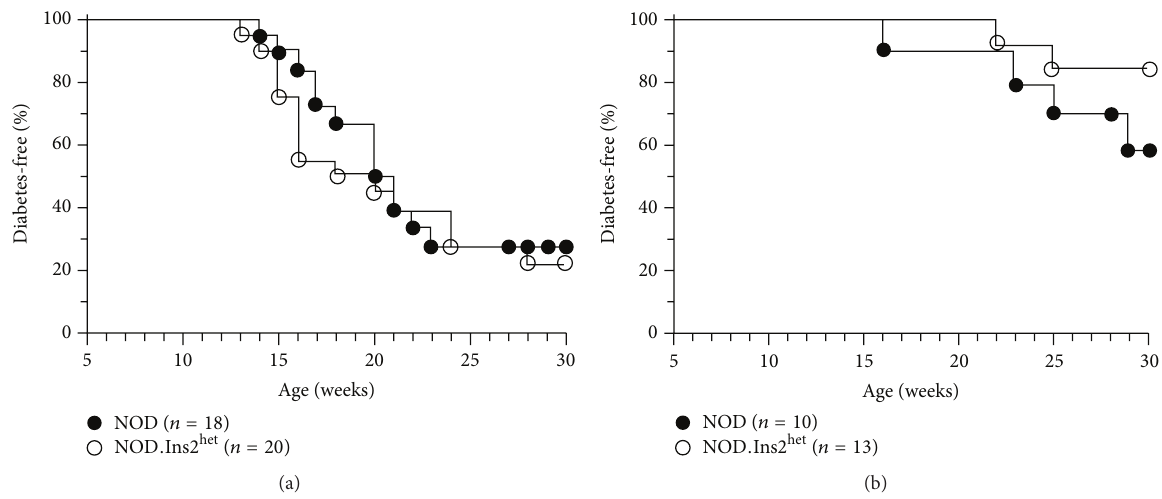
Figure 2: Diabetes development in NOD and NOD.Ins 2 het mice. (a) Female and (b) male NOD (filled circles) and NOD.Ins 2 het mice (open circles) were followed weekly for diabetes development. (a) 𝑝 = 0.63 (not significant), Mantel-Cox. (b) 𝑝 = 0.19 (not significant),